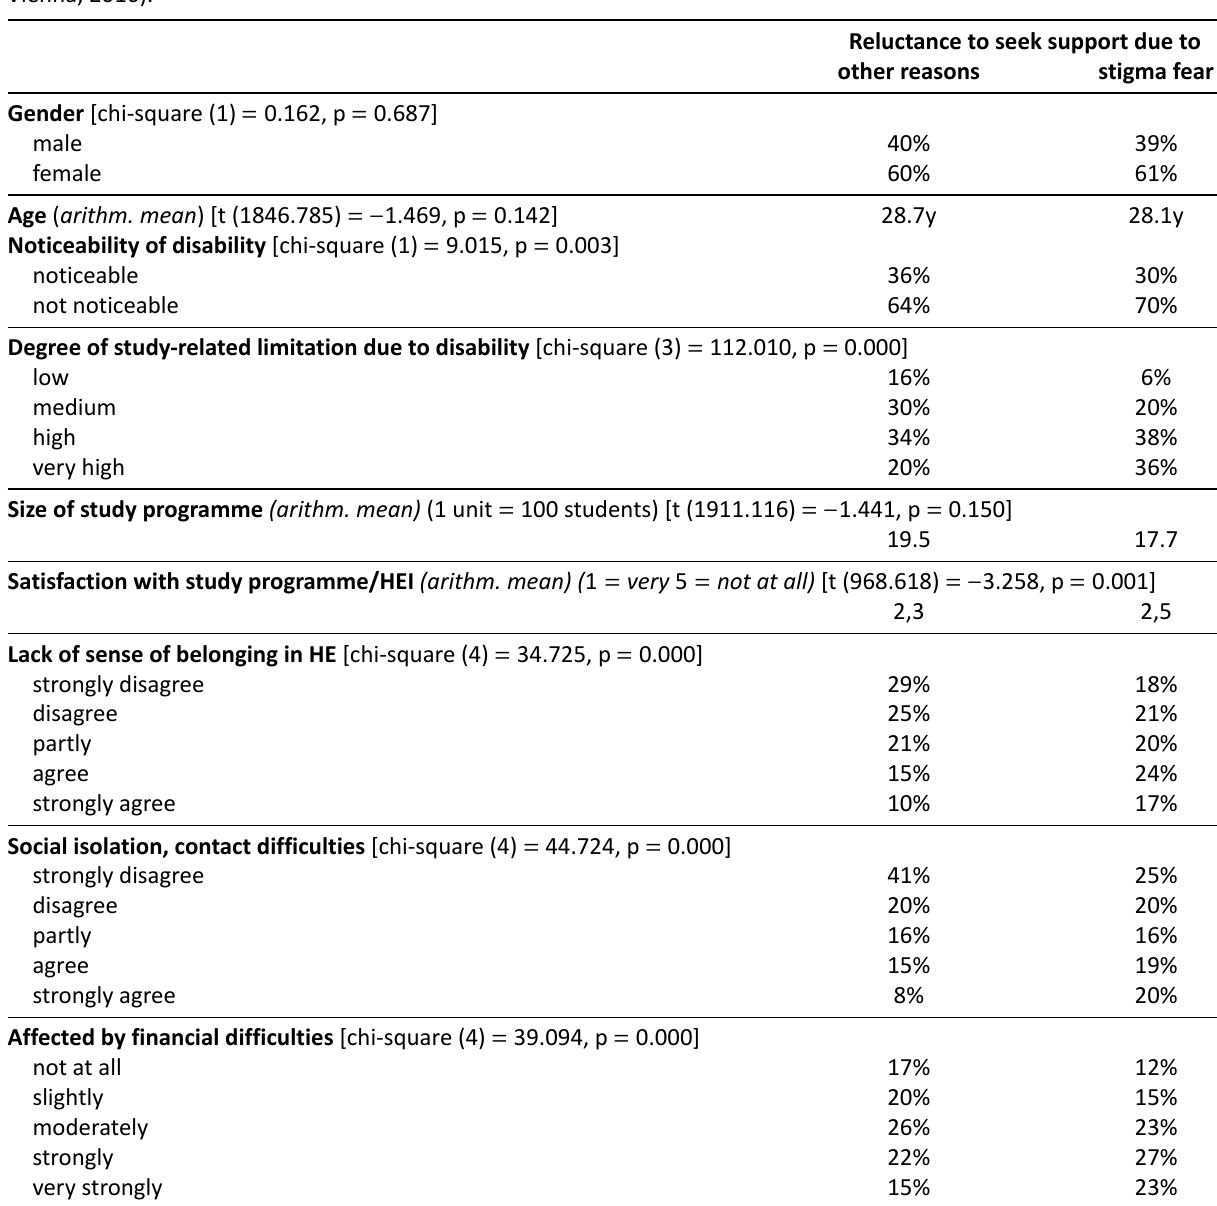
Table 2. Predictor variables. Data source: Austrian Student Social Survey 2015 (IHS—Institute for Advanced Studies Vienna, 2016).